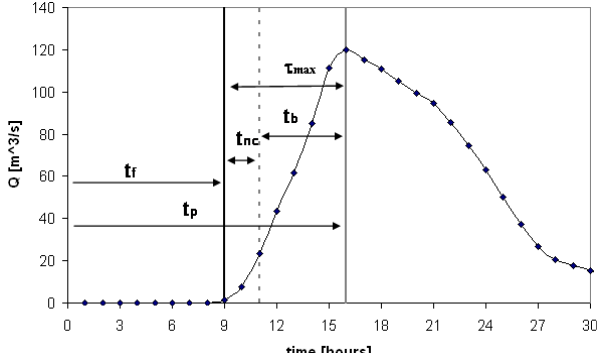
Fig. 3. Reference schematization for the verification methodology. t f is the time of forecast, t p is the peak time, t nc is the nowcasting window time, t b is the basin characteristic lag time, τ max is the theoretical maximum lag time for discharge